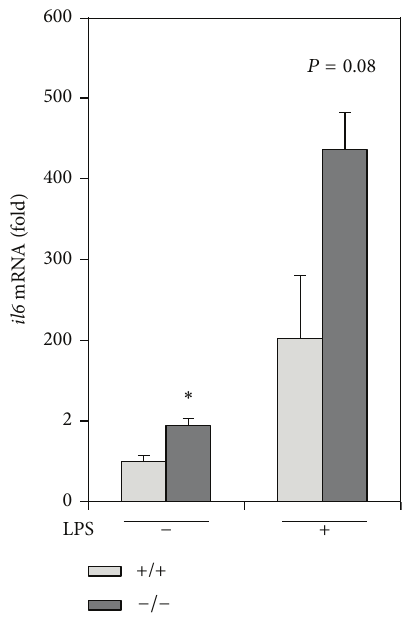
Figure 5: Peritoneal macrophages from rev-erb 𝛼 −/− mice increase il6 gene expression. Peritoneal macrophages were harvested as adherent cells from 2-month-old rev-erb 𝛼 −/− mice and their wild- type (+/+) mice. The cells were treated with or without 1 𝜇 g/mL LPS for 24 h. The gene expression of il6 was analyzed by qPCR. For normalization, actb mRNA was used. The data are presented as the means ± S.E. ( 𝑛 = 3 ). ∗ 𝑃 < 0.05 versus rev-erb 𝛼 +/+